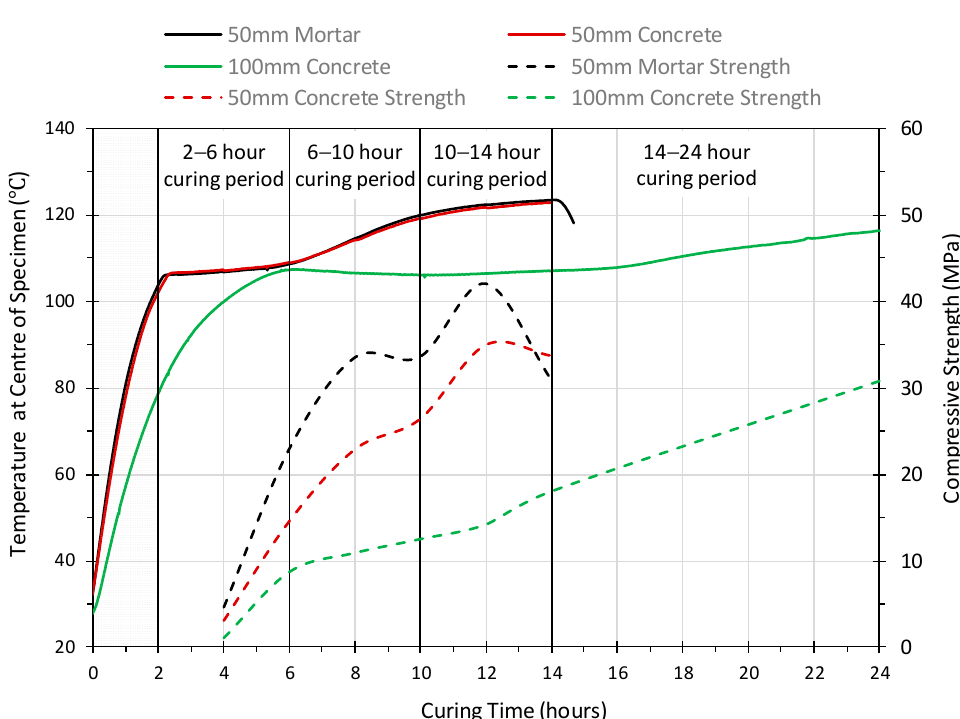
Figure 6. The compressive strength development profile of geopolymer mortar and concrete.